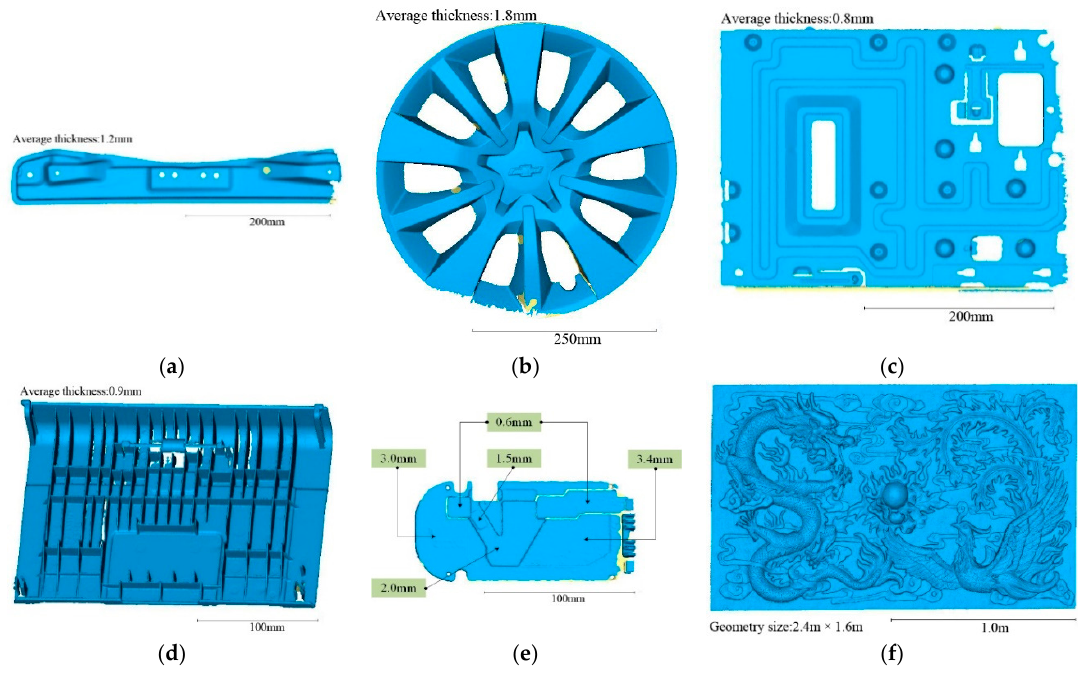
Figure 14. Six experimental objects: ( a ) metal bar; ( b ) automobile hub; ( c ) sheet metal part; ( d ) plastic shell; ( e ) metal panel; and ( f ) relief; the metal panel is composed of five parts with different thickness. The “relief” ( f ) is 2.4 m × 1.6 m in size. The total number of curves acquired from the “relief” is 472,612, and the total number of 3D surface points is 3,365,470,052. Since this object has large size and